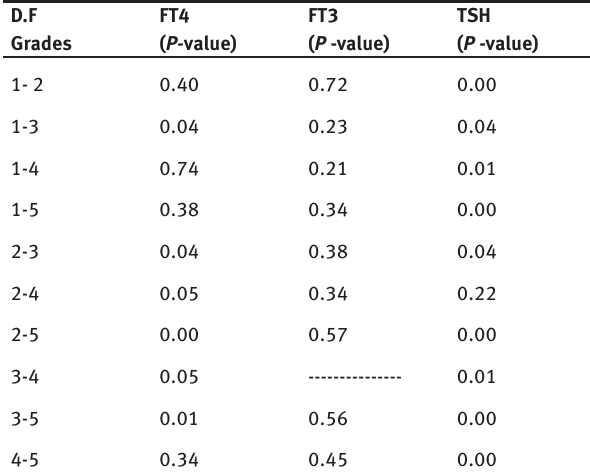
Table 3: Comparison of Different Grades of D.F with FT4, FT3 and TSH in Sample